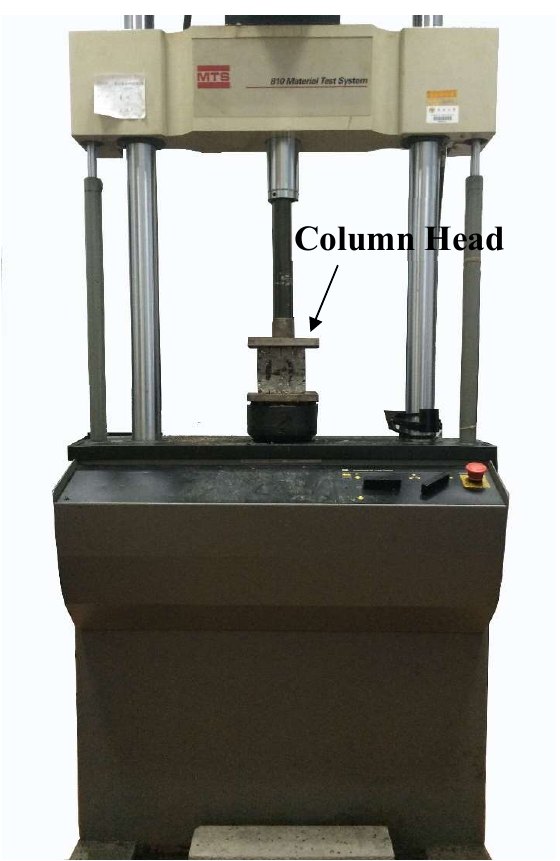
Figure 1. Cyclic loading test apparatus.